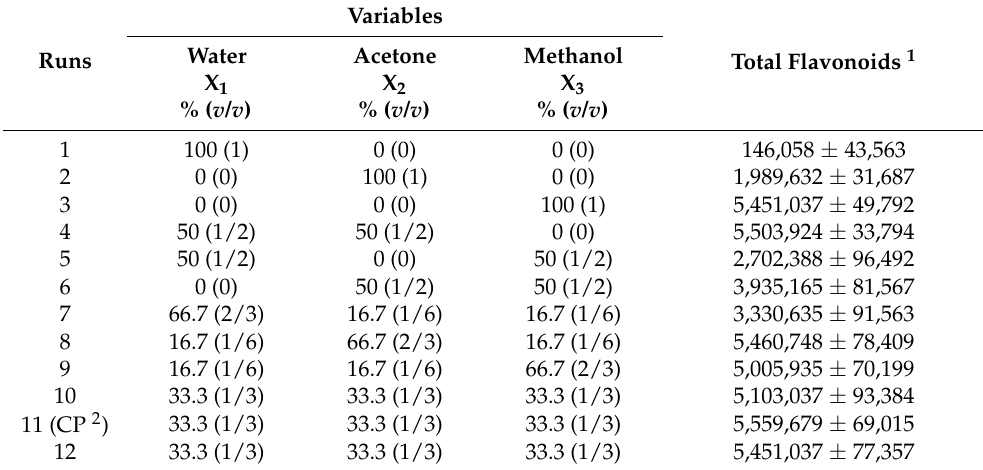
Table 1. Matrix of three variables in mixture design (simplex centroid) and experimental data for solvent mixture of maximum flavonoids extraction